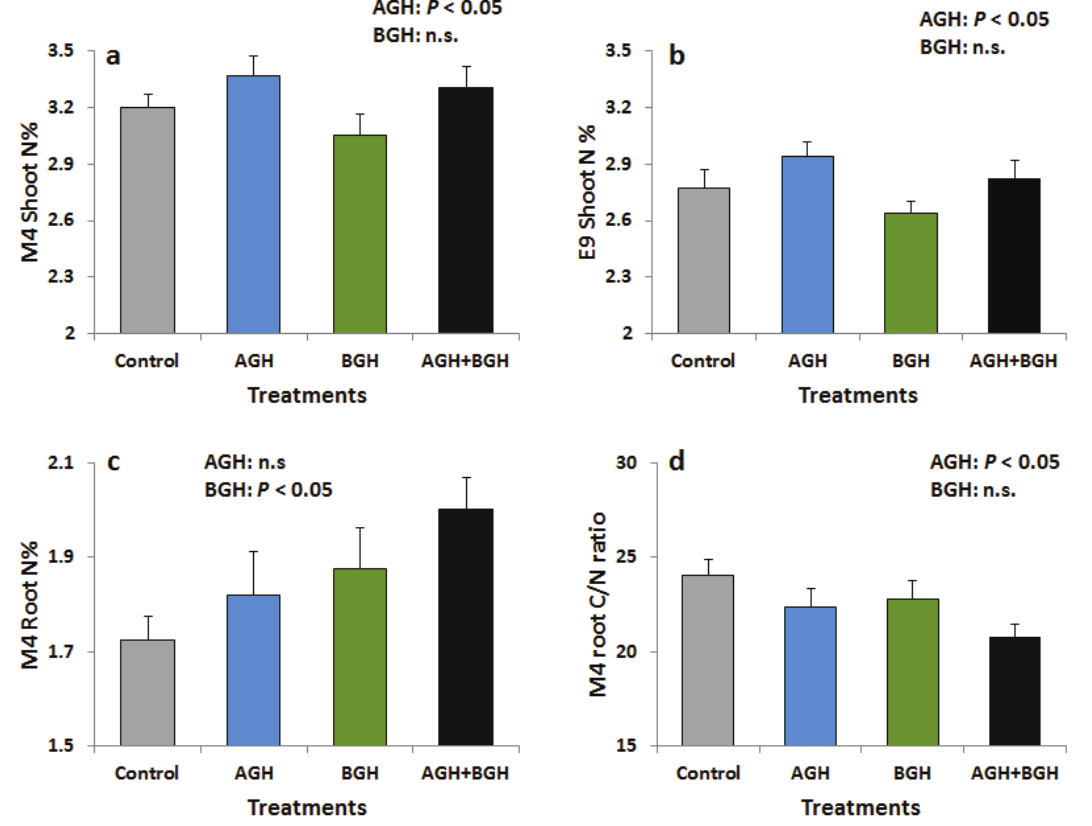
Figure 4. Shoot N (%) of the genotype M4 ( a ) and E9 ( b ), root N (%) of the genotype M4 ( c ) and root C/N ratio of the genotype M4 ( d ). Treatments: Control, AGH: aboveground herbivory only, BGH: belowground herbivory only and AGH+BGH: aboveground herbivory followed by belowground herbivory with the lag phase of seven days.